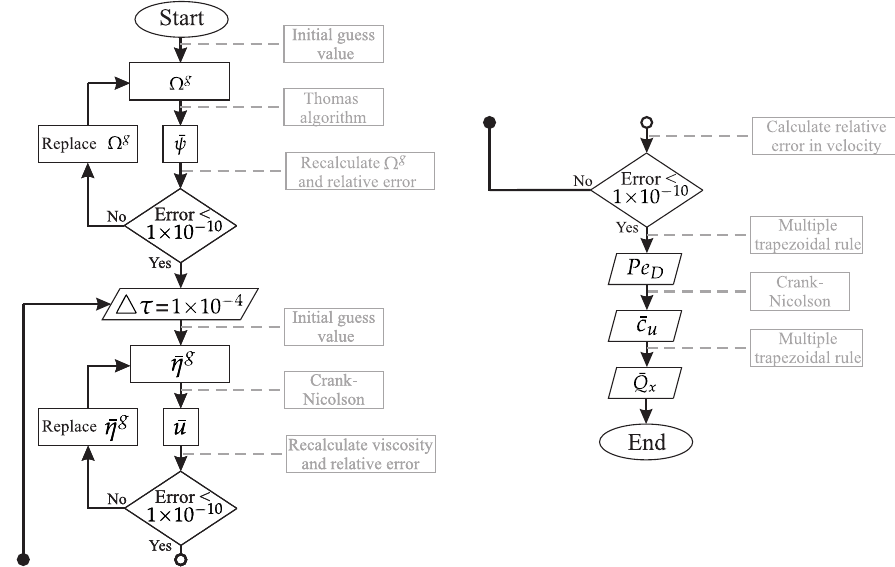
Figure 2. Schematic diagram of the numerical